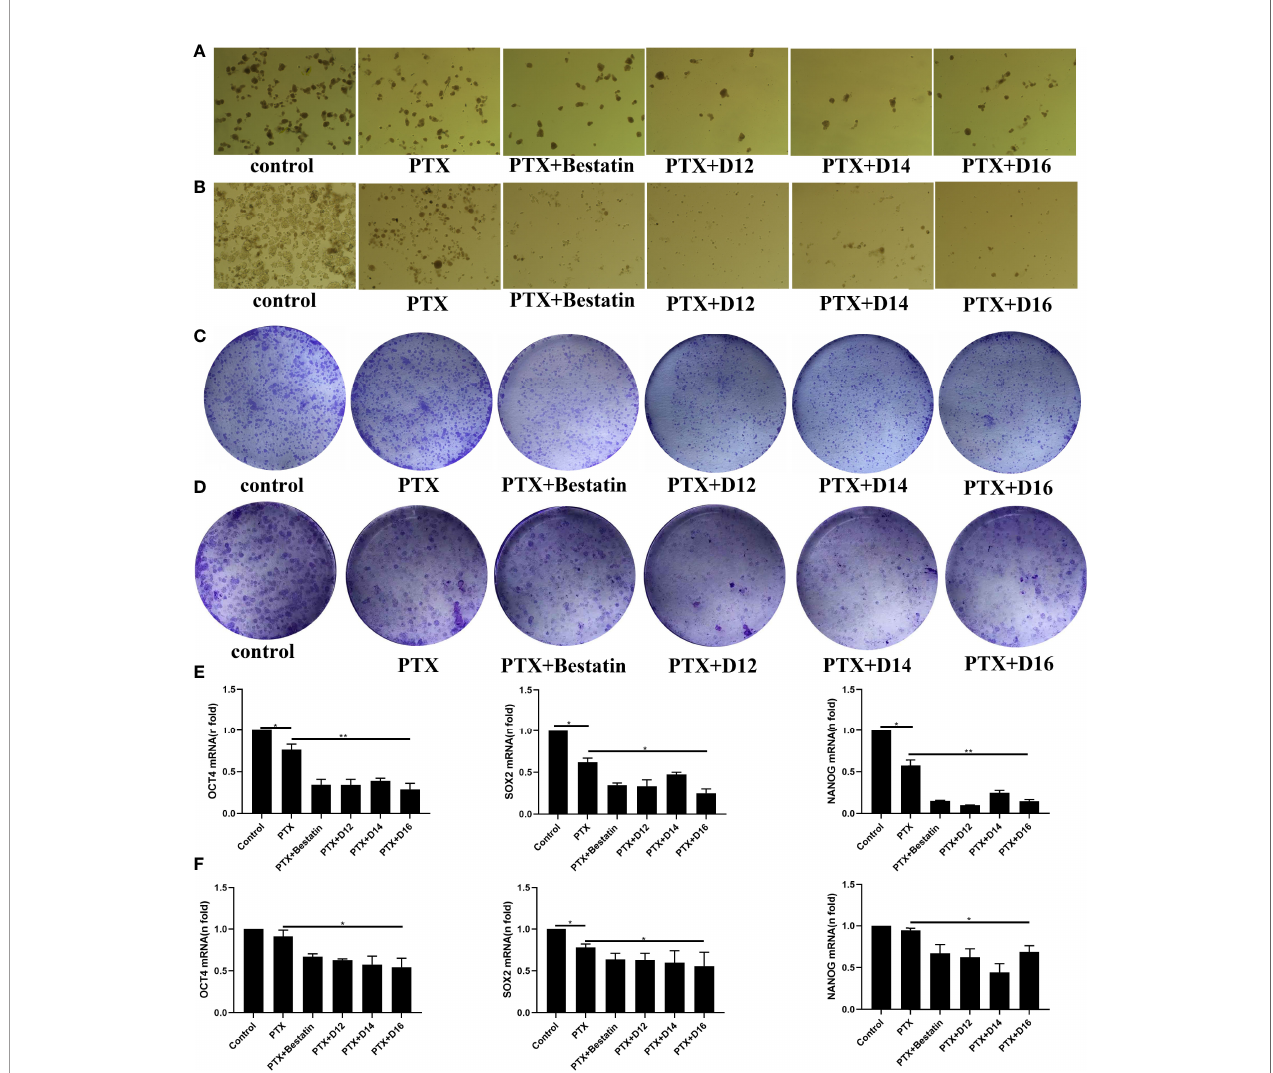
FIGURE 4 | Effects of PTX-APN inhibitor combinations on spheroid and colony formation of tested TNBC cells, and on mRNA expression levels of OCT-4, SOX-2 and Nanog in the tested TNBC stem cells. (A) MDA-MB-231 cell spheroid formation affected by different PTX-APN inhibitor combinations; (B) MDA-MB-468 cell spheroid formation affected by different PTX-APN inhibitor combinations; (C) MDA-MB-231 cell colony formation affected by different PTX-APN inhibitor combinations; (D) MDA-MB-468 cell colony formation affected by different PTX-APN inhibitor combinations; (E) regulation of mRNA expression levels of OCT-4, SOX-2 and Nanog by different PTX-APN inhibitor combinations in MDA-MB-231 cells; (F) regulation of mRNA expression levels of OCT-4, SOX-2 and Nanog by different PTX-APN inhibitor combinations in MDA-MB-468 cells; *P ≤ 0.05, **P ≤